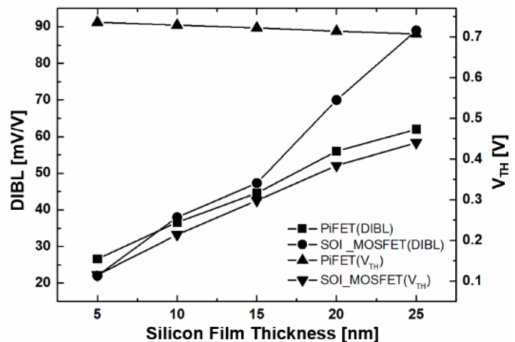
Figure 10. DIBL and threshold voltage dependence of silicon film thickness on the SOI MOSFET and the PiFET with slope 5.